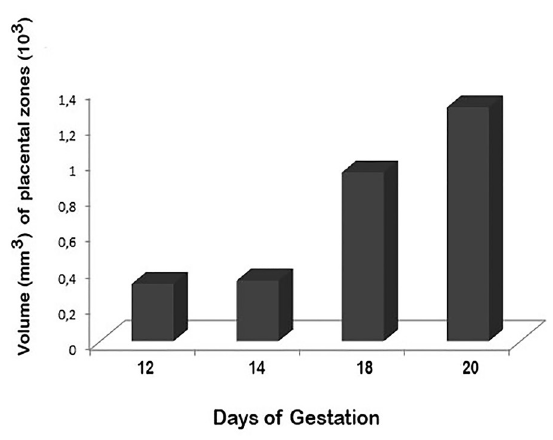
Figure 3. Total volume of the rabbit placental zones from day 12 to day 20 of